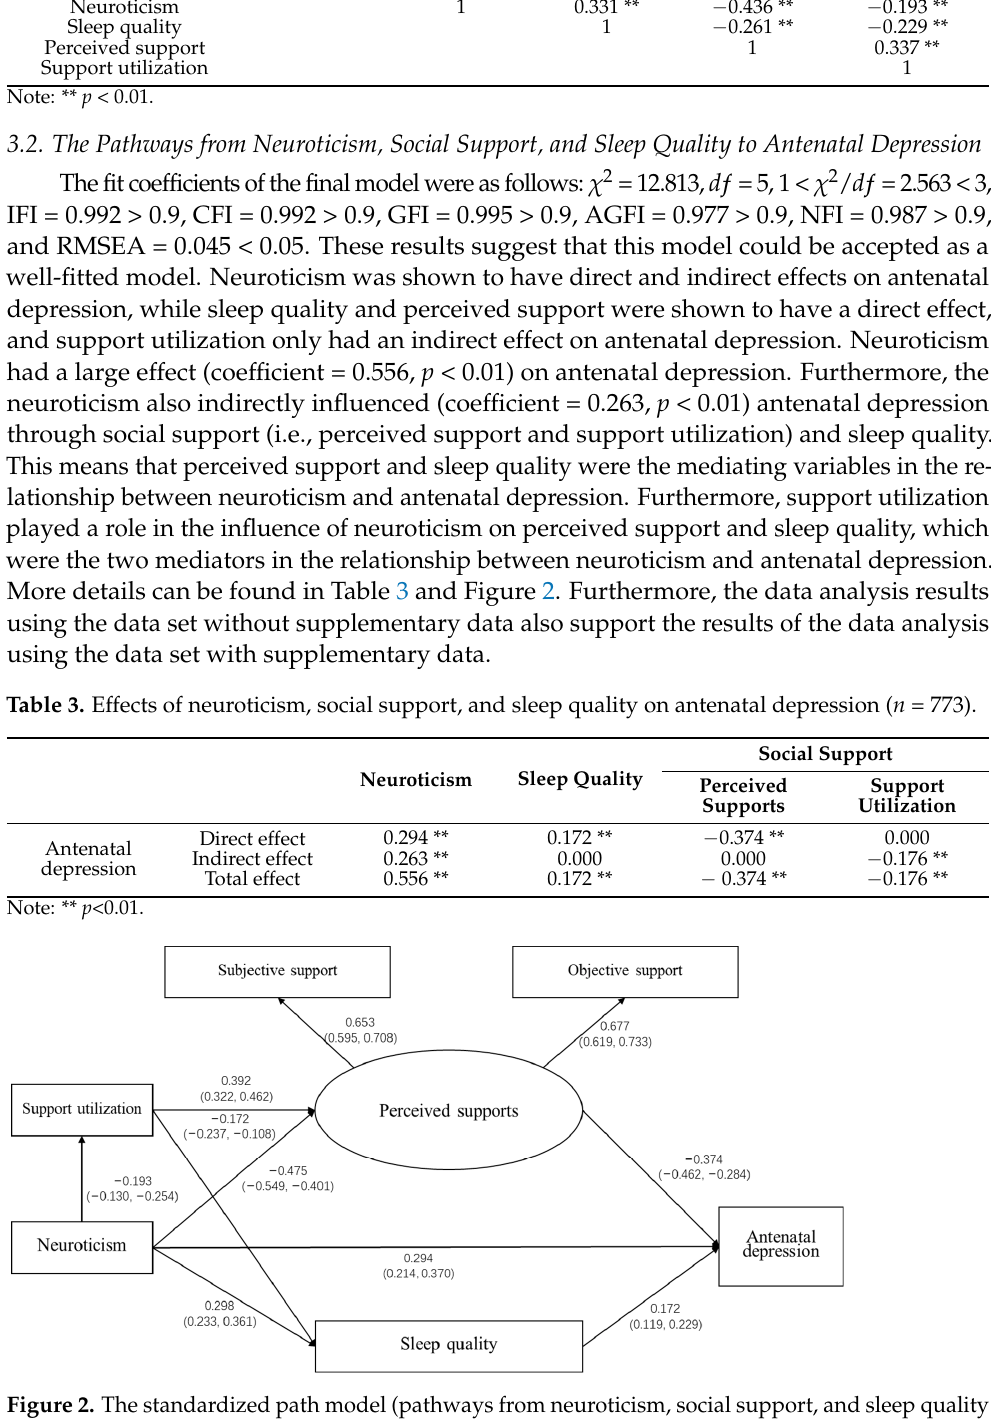
Table 2. Correlations between neuroticism, social support, sleep quality, and antenatal depression ( n = 773). Antenatal depression